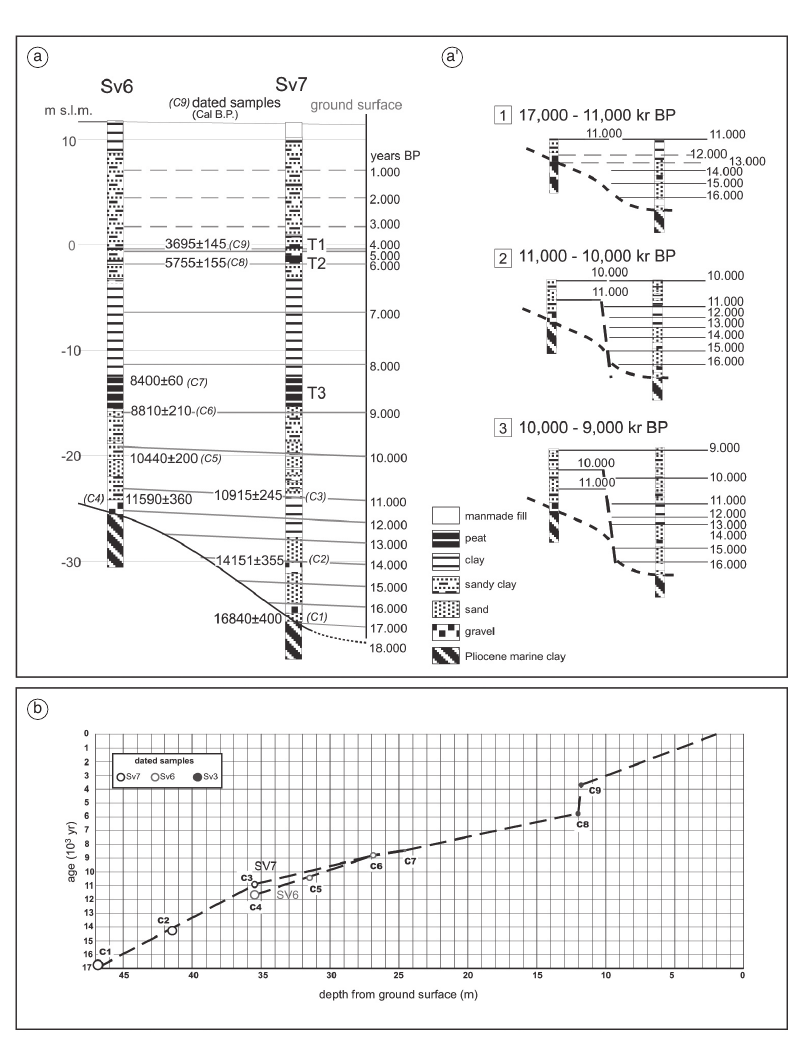
Fig. 7a,b. a) Detailed stratigraphy of boreholes Sv6 and Sv7 and lateral correlation of the horizontal isochrones (grey) based on the C14 age of dated samples (see table I). a') Palinspastic restoration of the inferred fault dis- placement, accounting for different elevation of the isochrones at the two boreholes. b) Sedimentation rate at the two boreholes estimated from the age of the dated samples (width of the circles is proportional to the variability associated with the sample